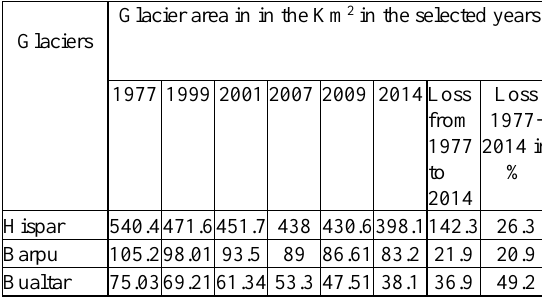
Table 1:Glacier dynamics in the selected glaciers